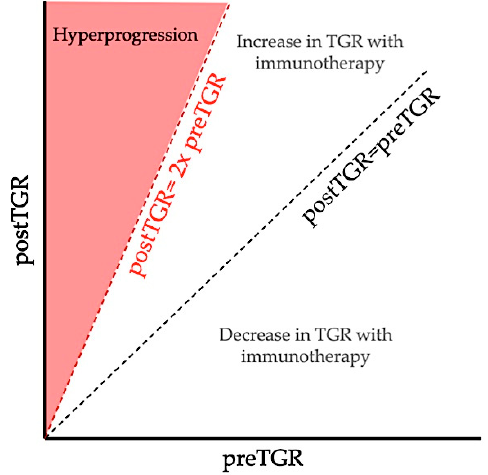
Figure 3. Definition of hyperprogression by Champiat et al. based on TGR variation. Comparison between pre-immunotherapy TGR (preTGR), computed with the anterior and baseline CT scan, and immunotherapy TGR (postTGR), computed with baseline CT scan and first evaluation during immunotherapy. Champiat defined hyperprogression as a RECIST progression at the first evaluation and at least two-fold TGR increase between pre-immunotherapy and immunotherapy period [14]. In the same way, Ferrara et al . compared pre- and post-immunotherapy TGR in a retrospective